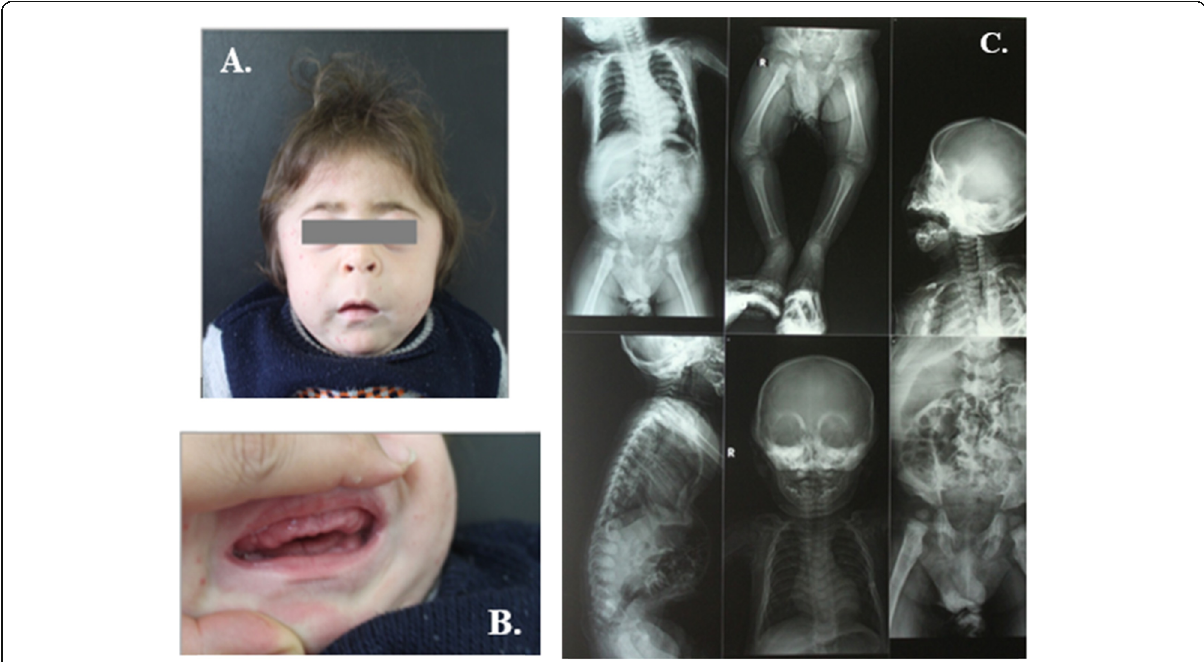
Fig. 1 Patient no. 1 at the age of 9 months. A Clinical features of ML II including coarse facial features, long philtrum, tower skull, and short neck. B Hypertrophic gingiva of the mouth. C X-rays of patient no. 1 showing dysostosis multiplex at ends of long bones and